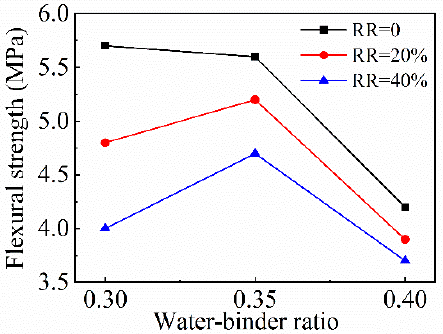
Figure 13. Variation of FRAC flexural strength with w / b